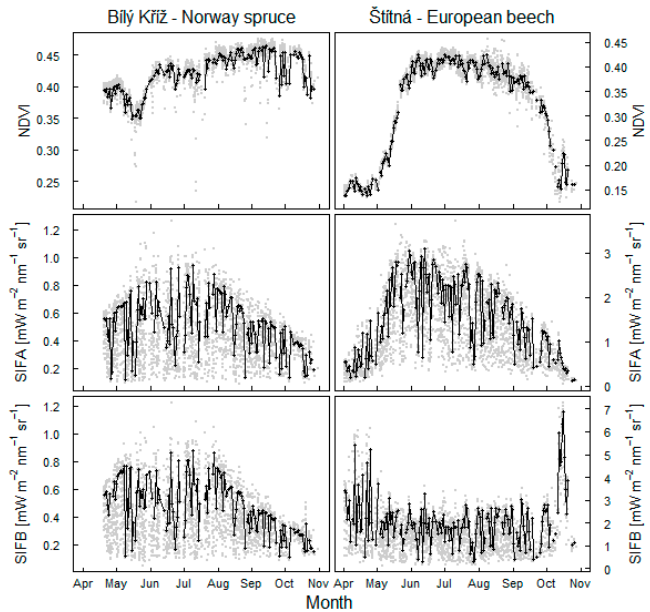
Figure 5. Dynamics of fluorescence in O 2 A band (SIFA) and fluorescence in O 2 B band (SIFB) shown in direct comparison with seasonal trend in NDVI at spruce and beech forests. Black dots show mean dynamics in a 2 h long period at midday. Grey points refer to dynamics at 30 min intervals within days with PAR intensities > 300 µmol m − 2 s − 1 and SZA > 25°.